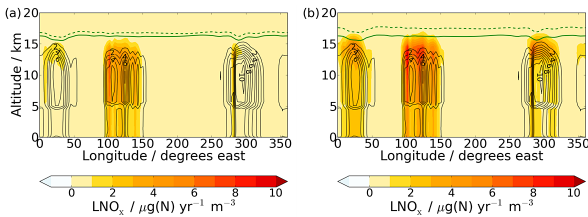
Figure 1. Annual mean, longitude–altitude cross sections of tropi- cally averaged (20 ◦ S–20 ◦ N) LNO x (contours) of the Base run and changes (shading) from Base to (a) 1 CC4.5 and (b) 1 CC8.5. Re- gions which show notable changes in LNO x are: Central Africa (0– 50 ◦ E), the Maritime Continent (100–150 ◦ E) and South America (280–320 ◦ E). Solid (Base run) or dashed (future runs) green lines indicate the height of the thermal tropopause, which is calculated Based on the WMO lapse rate definition (WMO,